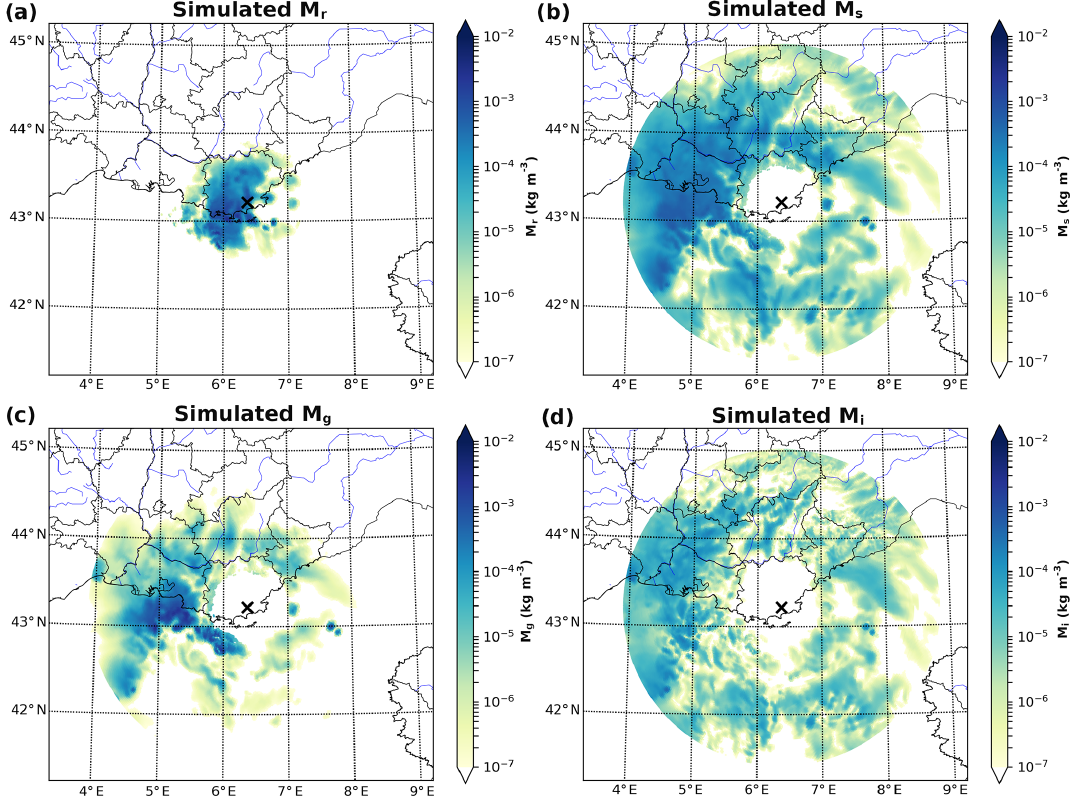
Figure 2. Hydrometeor mixing ratios from a 1h AROME-France forecast valid the 10 October 2018 at 14:00UTC for (a) rain, (b) snow, (c) graupel and (d) pristine